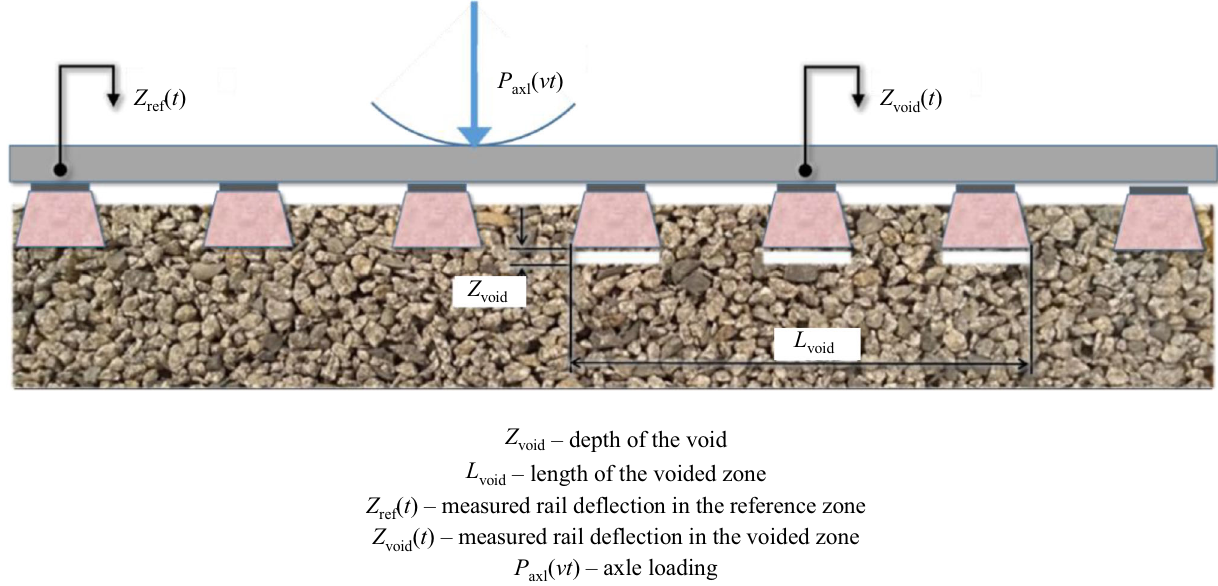
Fig. 3 Measurement of rail deflection in the voided zone and the reference